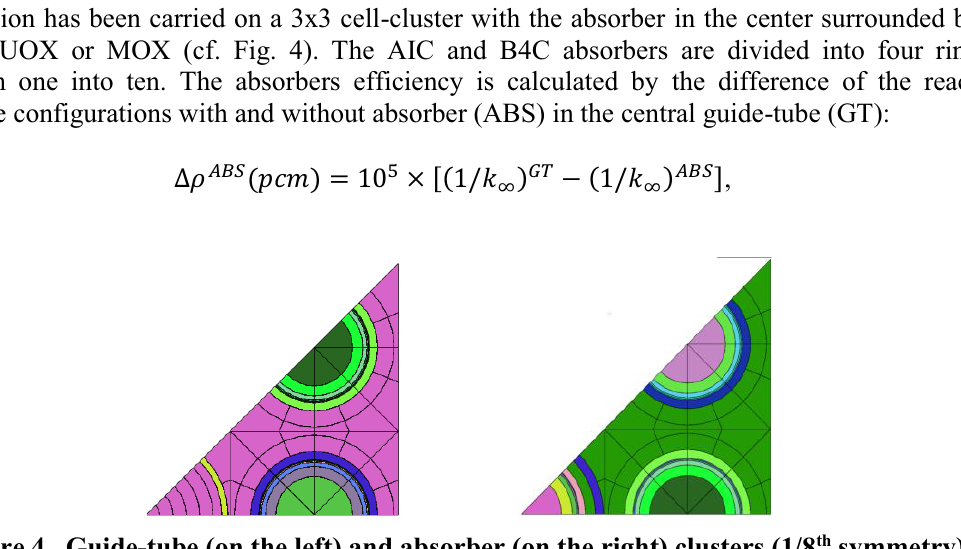
Figure 4. Guide-tube (on the left) and absorber (on the right) clusters (1/8 th symmetry).